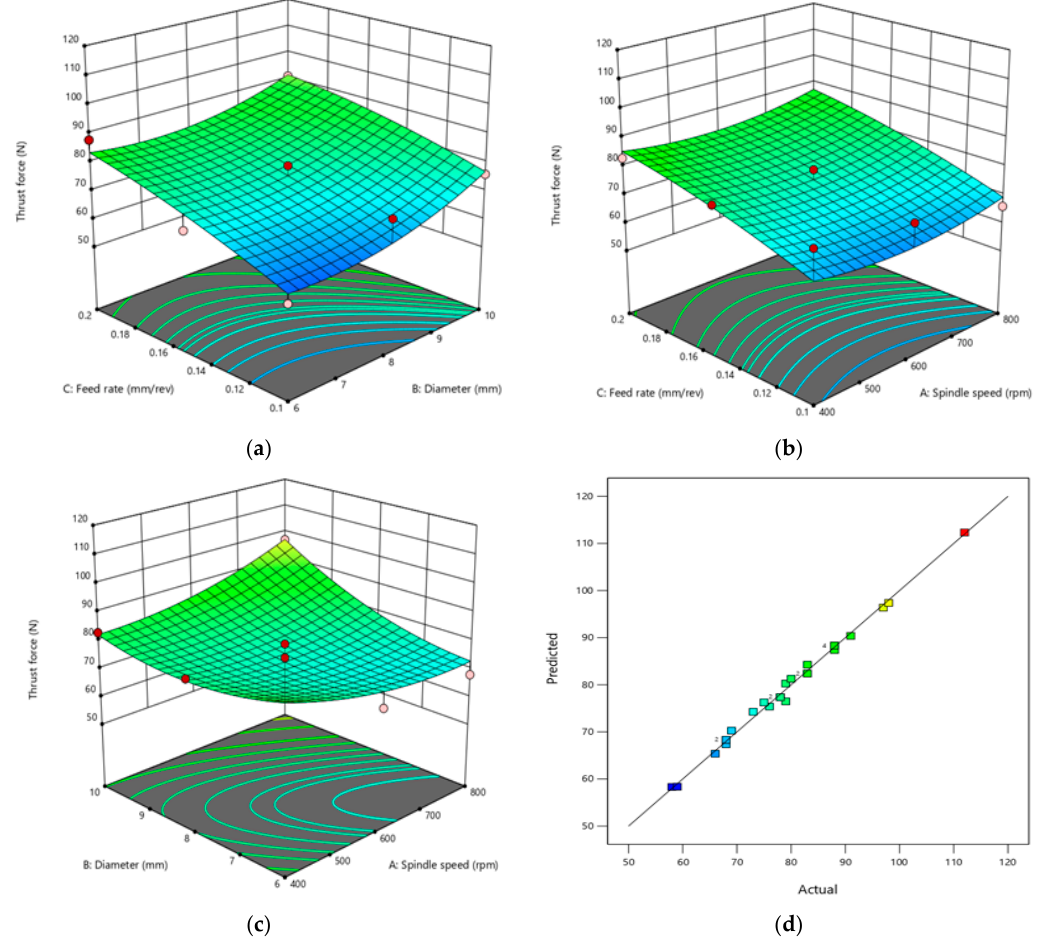
Figure 11. The 3D surface maps. ( a ) The interaction between feed rate and diameter on thrust force. ( b ) The interaction between feed and spindle speed. ( c ) The interaction between spindle speed and diameter. ( d ) Actual vs. predicted thrust force.